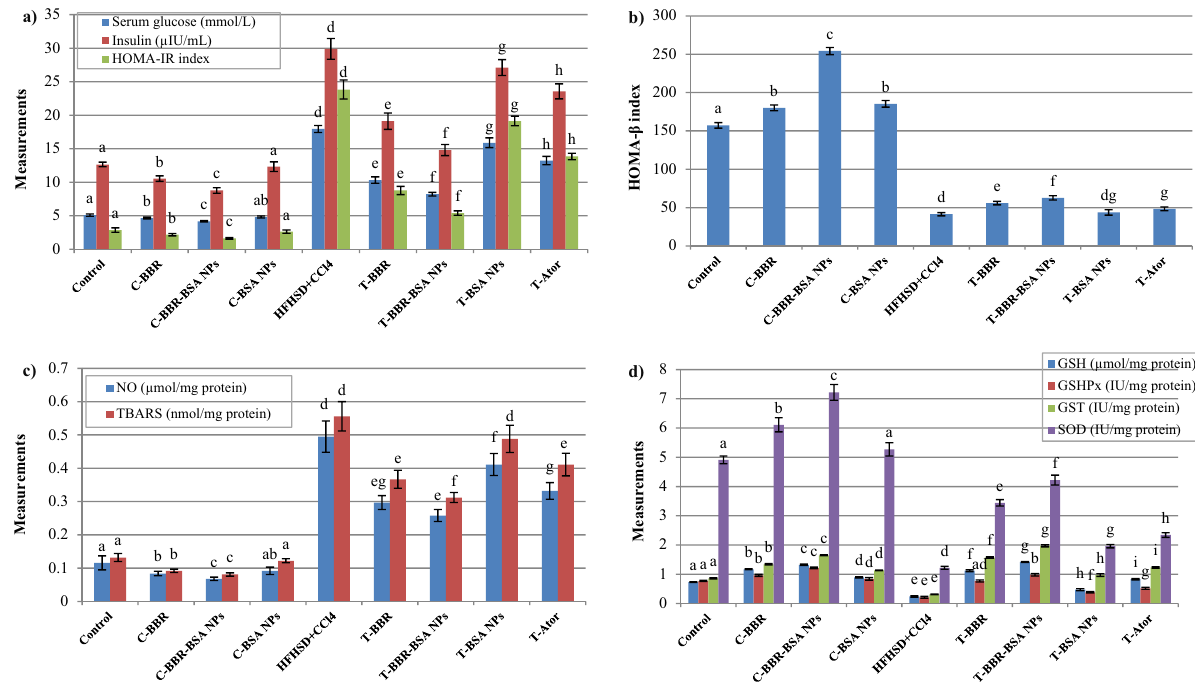
Figure 6. The effect of BBR and BBR-BSA NPs on the stressed pancreatic rat model. Serum glucose, insulin, and HOMA-IR index levels ( a ); Serum HOMA-β index ( b ); Pancreatic NO and TBARS levels ( c ); Pancreatic GSH level, GSHPx, GST, and SOD activities ( d ). Data values are expressed as means ± SD (n = 5). Different letters indicated statistically significant differences ( P < 0.05) between the experimental groups within the same parameter, which were evaluated using the analysis of one-way ANOVA with the post hoc LSD